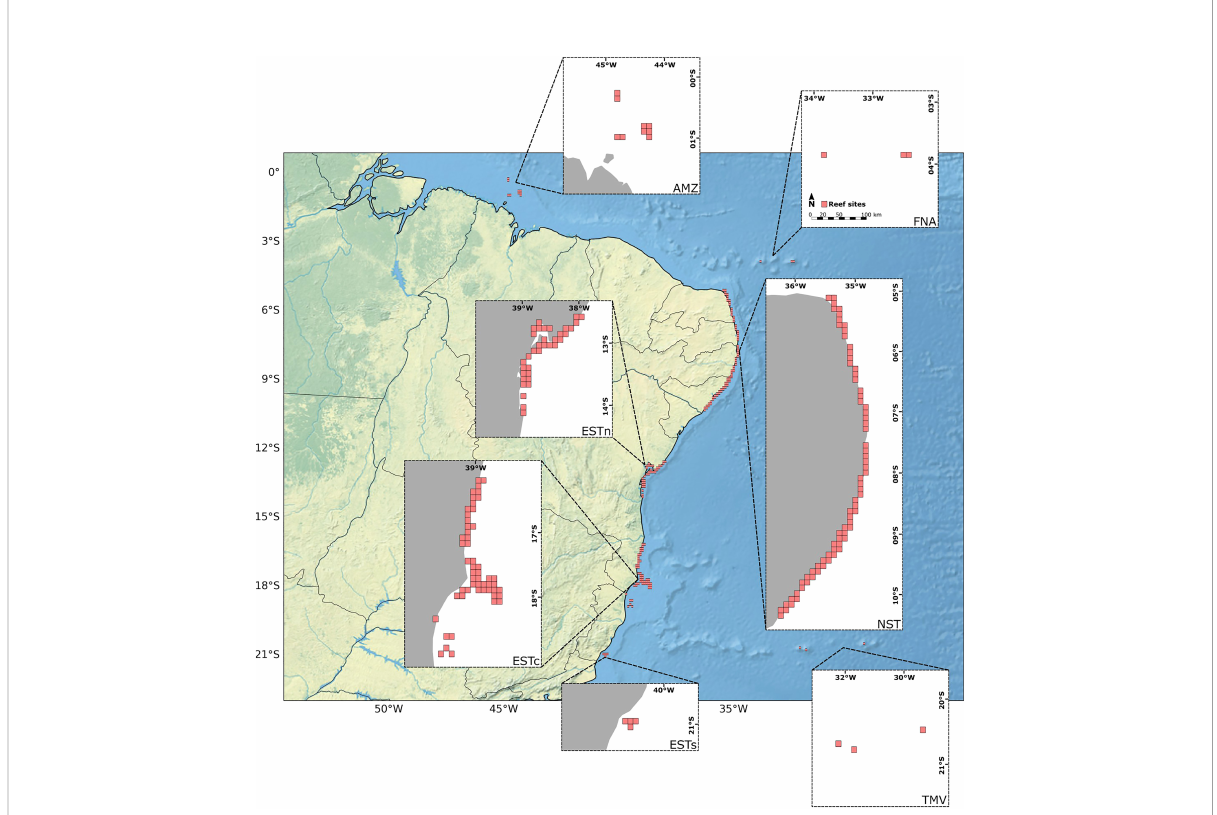
FIGURE 2 Distribution of the 180 reef sites with 10 x 10 km along the Brazilian continental margin (in gray). Ecoregions: Eastern-south (ESTs); Eastern- center (ESTc); Eastern-north (ESTn); Northeastern (NST), Amazon (AMZ), Fernando de Noronha-Atol das Rocas (FNA), Trindade-Martim Vaz Islands